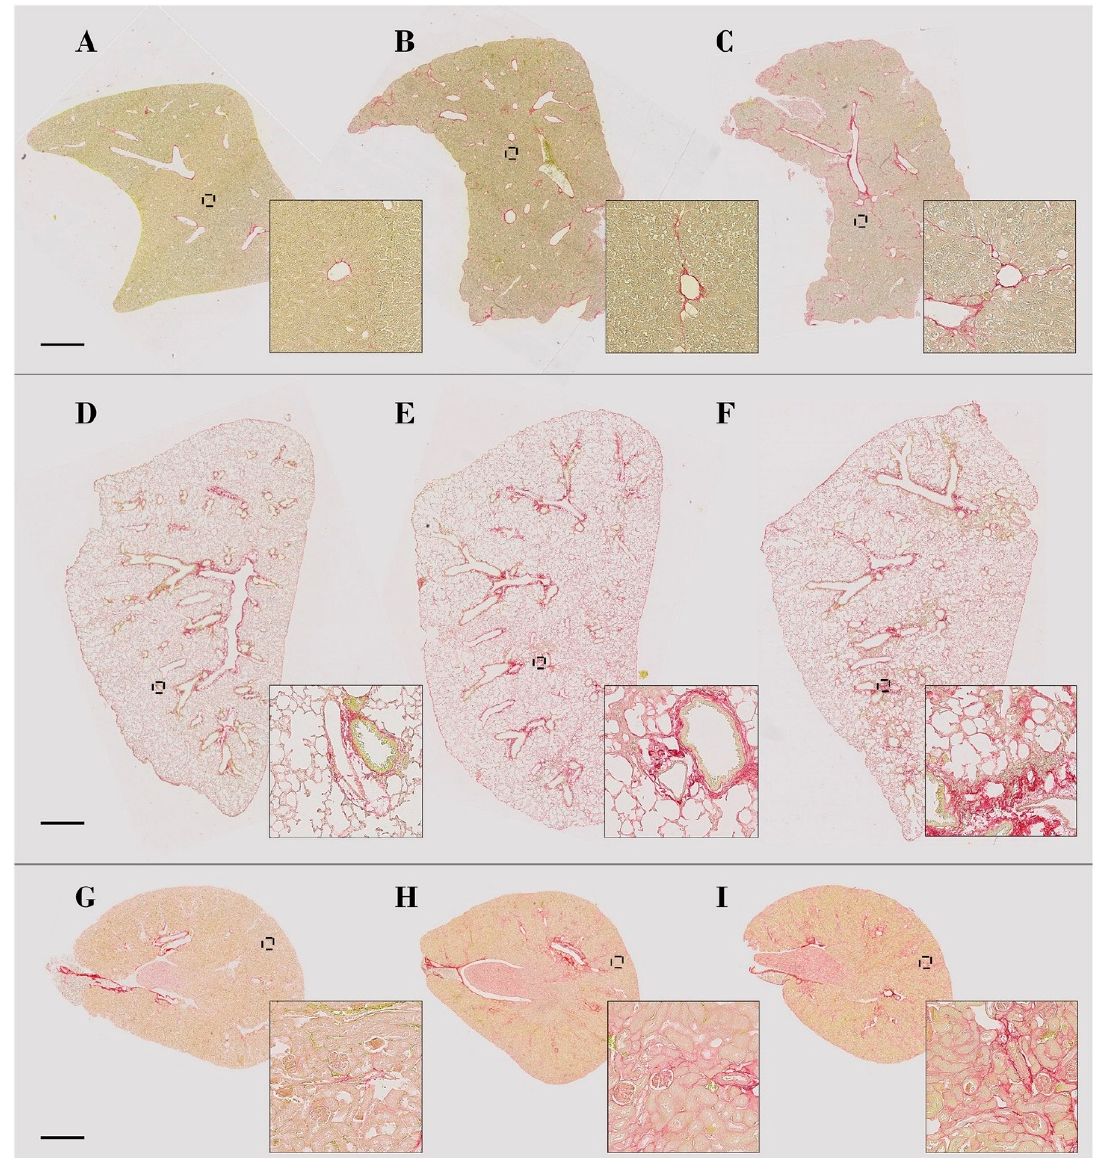
Figure 1. Illustration of fibrosis development in the murine models of liver ( A - C ), lung ( D - F ) and kidney ( G - I ) fibrosis. Representative samples of control ( A ), 2w CCl 4 ( B ), and 7w CCl 4 ( C ) livers; control ( D ), BLM-acute ( E ), and BLM-chronic ( F ) lungs; control ( G ), 3w CIS ( H ), and 4w CIS ( I ) kidneys. Global view of entire histological sections (scale bar = 1 mm) and higher magnification